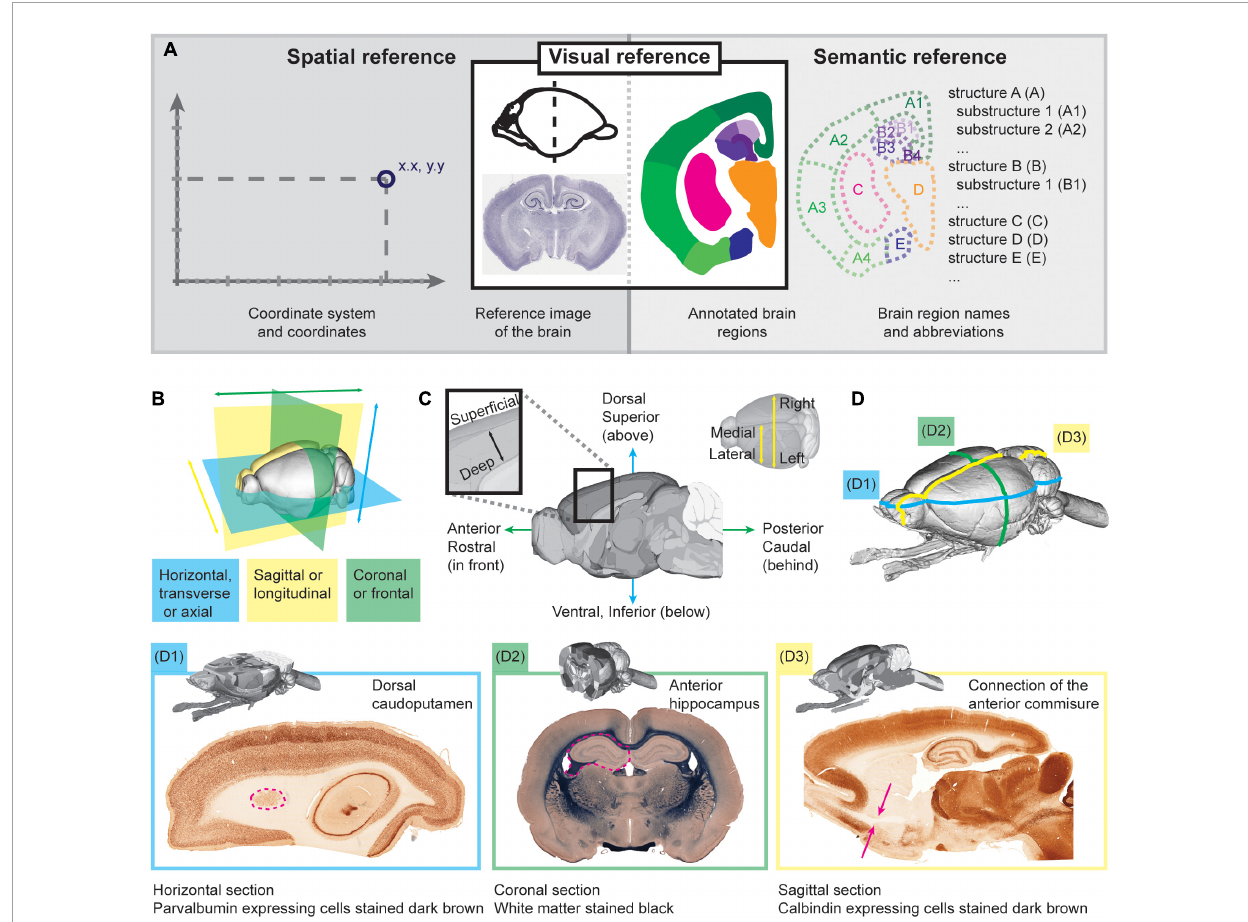
FIGURE1 Navigating brain atlases to find anatomical locations. (A) Simplified version of the brain atlas ontology model (AtOM, Kleven et al., 2023a). The main elements of an atlas include the coordinate system, the reference image (here exemplified with a coronal platypus brain section; Mikula et al., 2007), the annotated brain regions, and the brain region names. The elements provide different entry points for navigating the atlas, through a spatial, semantic or visual reference. (B) Illustration of the three standard planes (horizontal, blue; sagittal, yellow; coronal, green) typically used to cut brain sections. (C) Illustration of the essential terminology typically used for indicating positions in the brain (e.g., the terms “rostral” and “caudal” to refer to positions towards the front and back of the brain, respectively). (D) Illustration of useful landmark regions in the murine brain [adapted from Bjerke et al. (2023)], with examples from the horizontal (D1) , coronal (D2 ; Leergaard et al., 2018), and sagittal (D3)